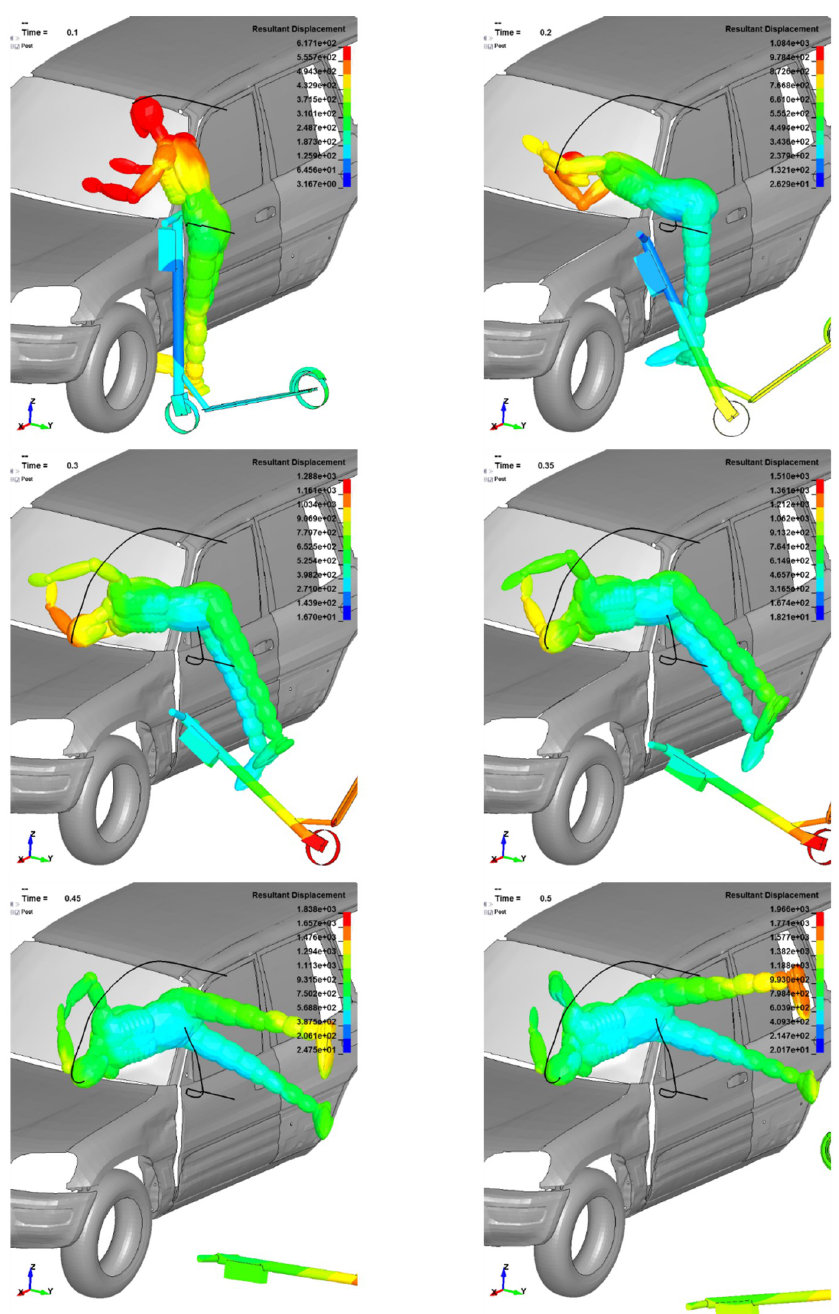
Fig 5. Dummy kinematics in the side bonnet scenario—The dummy’s resultant displacement in [mm], time in